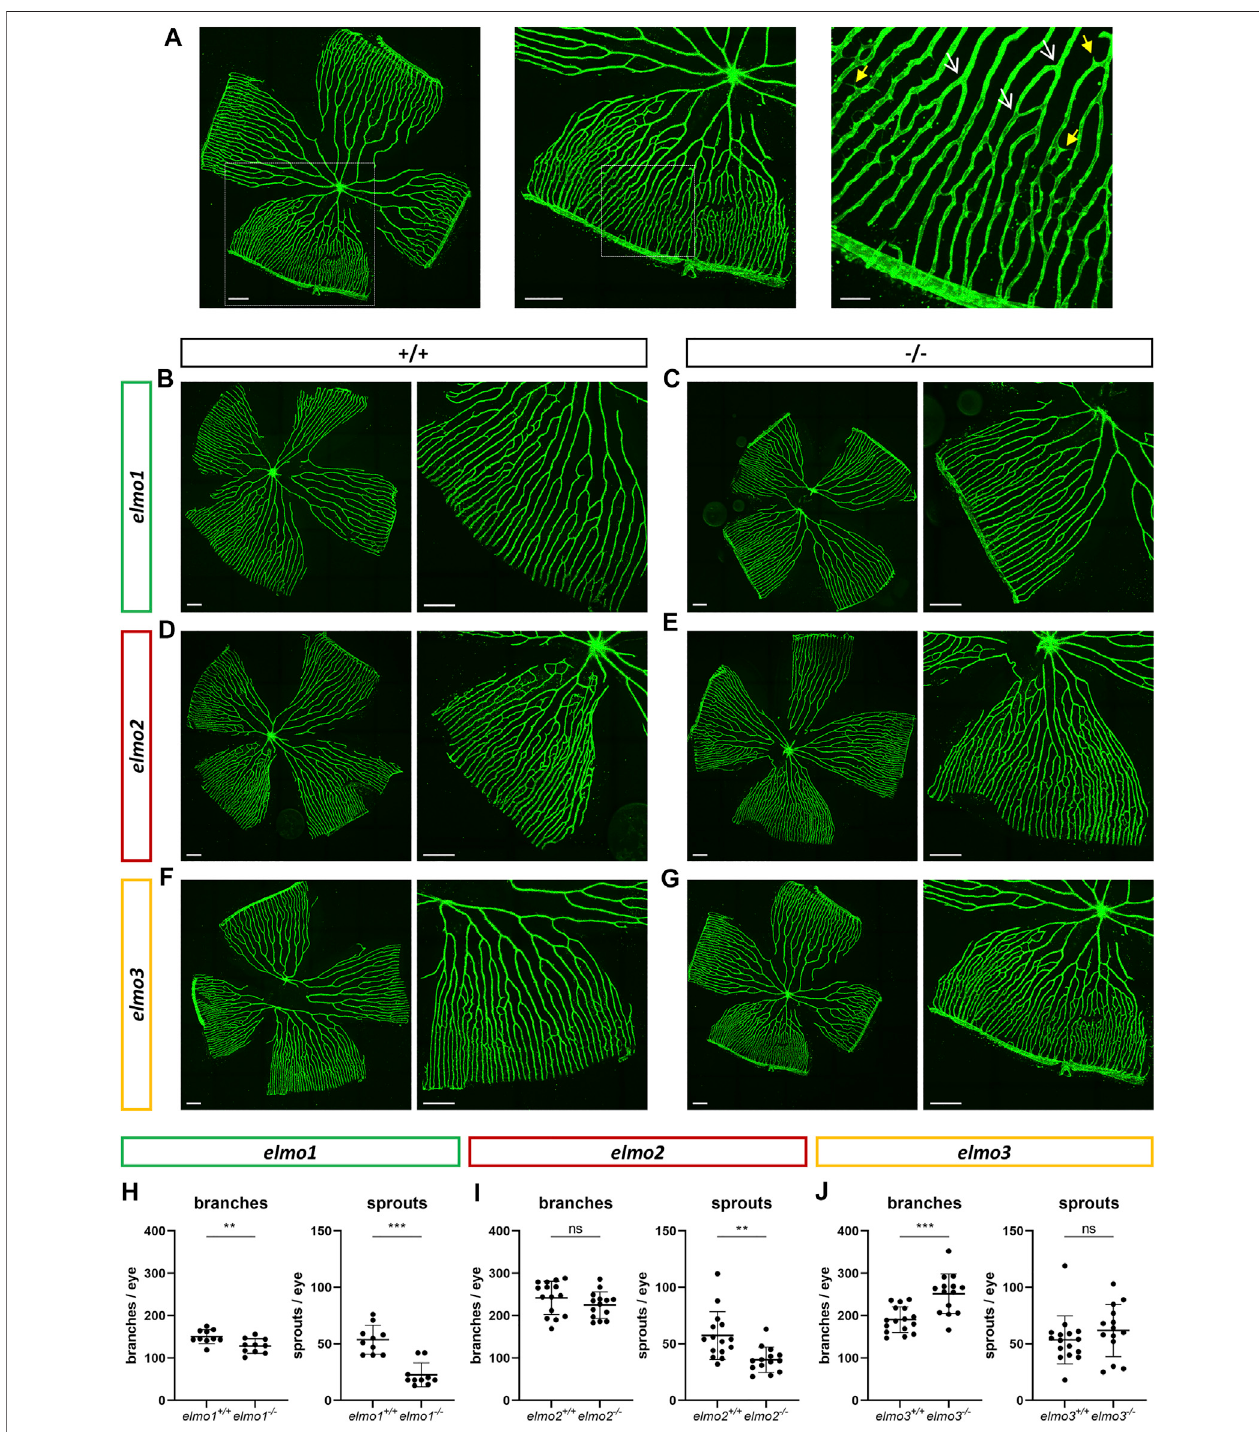
FIGURE 3 | Different regulation of the retinal vasculature through Elmo1, Elmo2 and Elmo3 in adult zebra fi sh. (A) Exemplary pictures of a confocal scan of an adult zebra fi sh retinal vasculature. White squares each indicate the section of the image on the right. Scale bars are 200 µm (left, middle) and 50 µm (right). Representative vascular branches are indicated with a yellow arrow with a full arrowhead and sprouts are indicated with a white arrow with an open arrowhead. (B – G) Representative confocal microscopy images of the retina vasculature of elmo1 +/+ (B) and elmo1 − / − (C) , elmo2 +/+ (D) and elmo2 − / − (E) and elmo3 +/+ (F) and elmo3 − / − (G) adult zebra fi sh. (H) Quanti fi cation of the adult retina vasculature showed a decrease in branches and sprouts in elmo1 − / − compared to elmo1 +/+ . n = 10 retinae per group. (I) Quanti fi cation of the adult retina vasculature showed no changes in branches and a decrease in sprouts in elmo2 − / − compared to elmo2 +/+ . n = 14 – 15 retinae per group. (J) Quanti fi cation oftheadultretinavasculatureshowedanincreaseinbranchesandnochangesinsproutsin elmo3 − / − comparedto elmo3 +/+ . n =14 – 16retinae per group. Analyzed retinae were obtained from animals of 9 – 15 mpf. Scale bar is 200 µm. Statistical analysis was done with t -test and Mann-Whitney test. ** p < 0.01, *** p < 0.001. ns, not signi fi cant; mpf, months post fertilization.